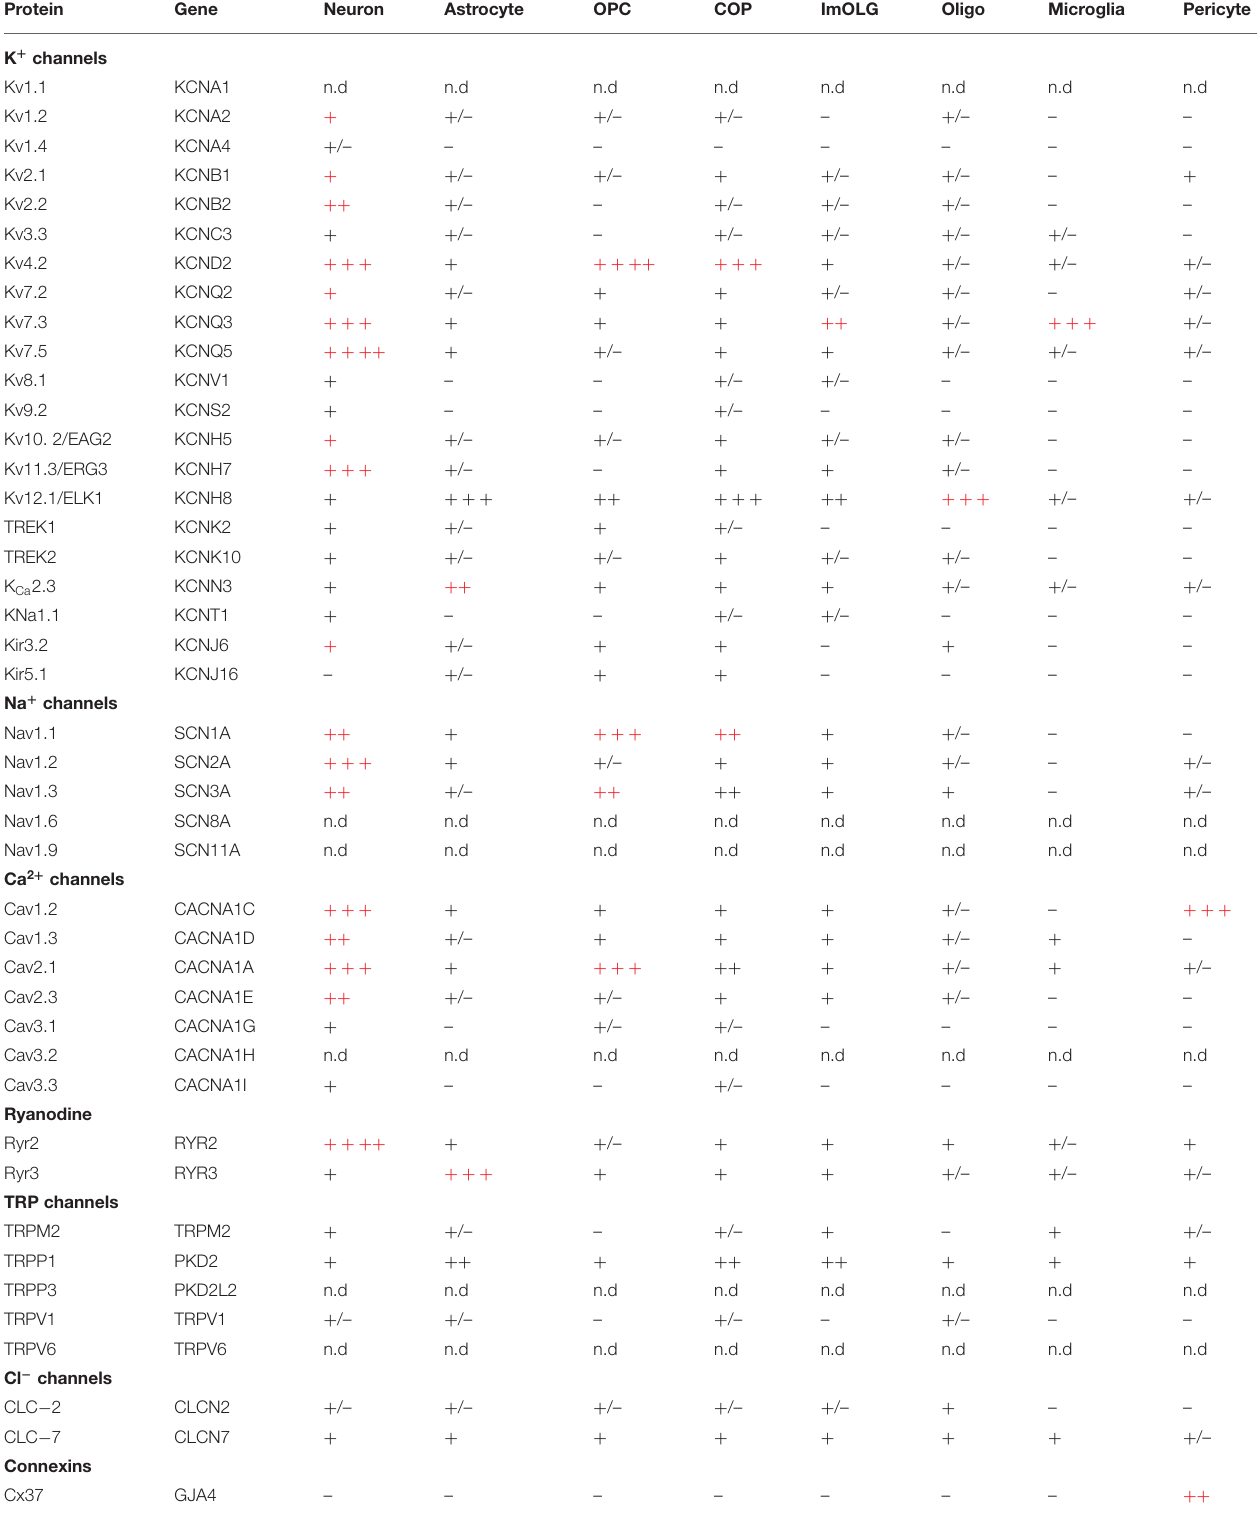
TABLE 2 | Profiling expression of unique gene in lesions in WM clusters of healthy and SPMS brain a .